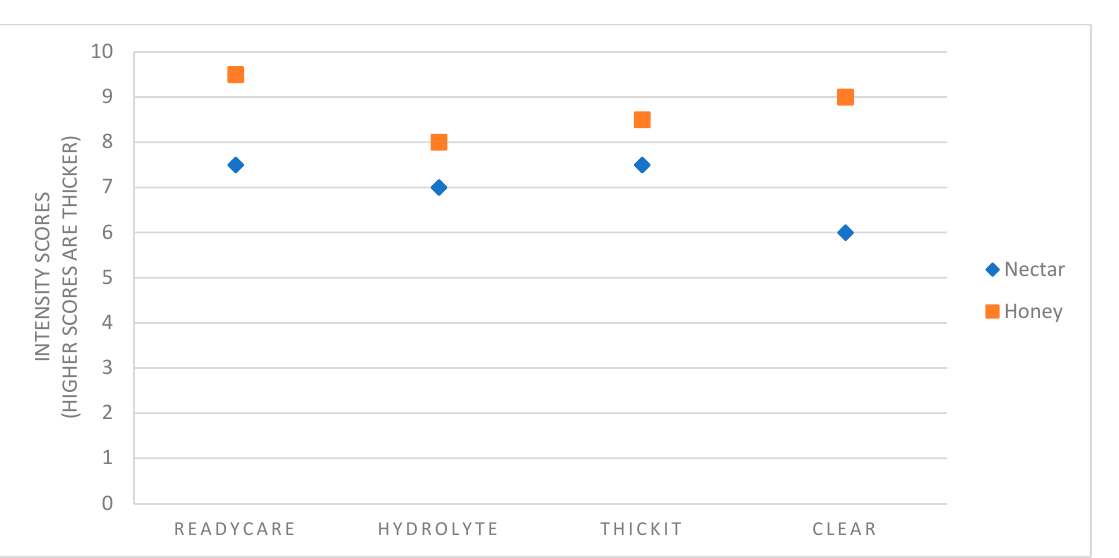
Figure 1. Comparison of viscosity evaluated by the descriptive panel .